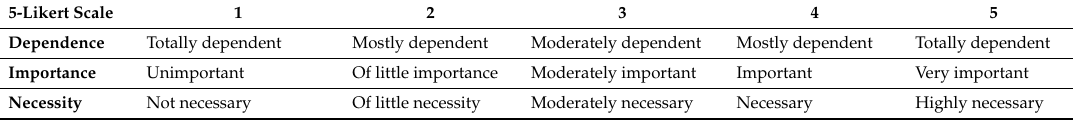
Table A1. Ratings for dependence, importance, and